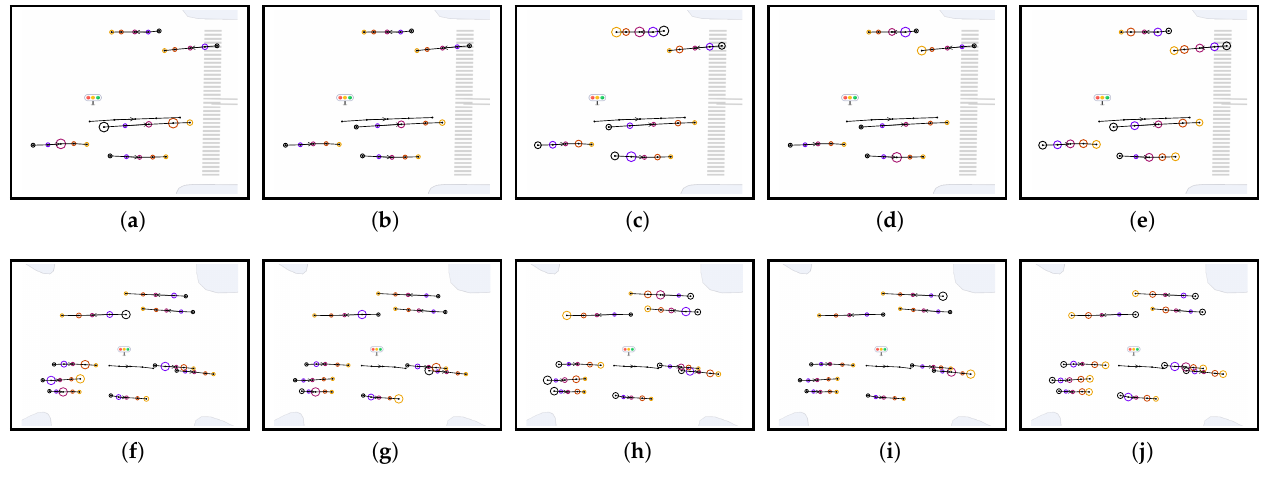
Figure 10. Attention weights assigned by the graph attention mechanism. ( a – j ) The five figures in each row show five attention weights assignment schemes for the same trajectory, i.e., four attention weights assignment schemes for the first layer and one for the second layer. The solid dots show the vehicle positions at different time steps, and the arrows show the direction. The color of the circle shows the time step, and its size shows the attention weight of the vehicle to a vehicle without circles on its